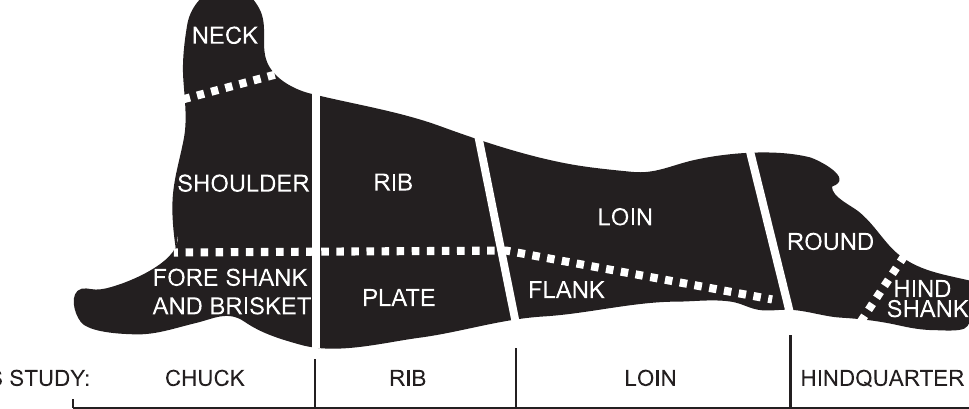
Fig. 2. Wholesale primal cuts of reindeer and the location of each of these in the carcass. A solid or dash line indicates a division between wholesale primal cuts for beef according to the U.S. National Live Stock and Meat Board (Hedrick et al ., 1994). The solid lines also indicate where actual cuts were made in this